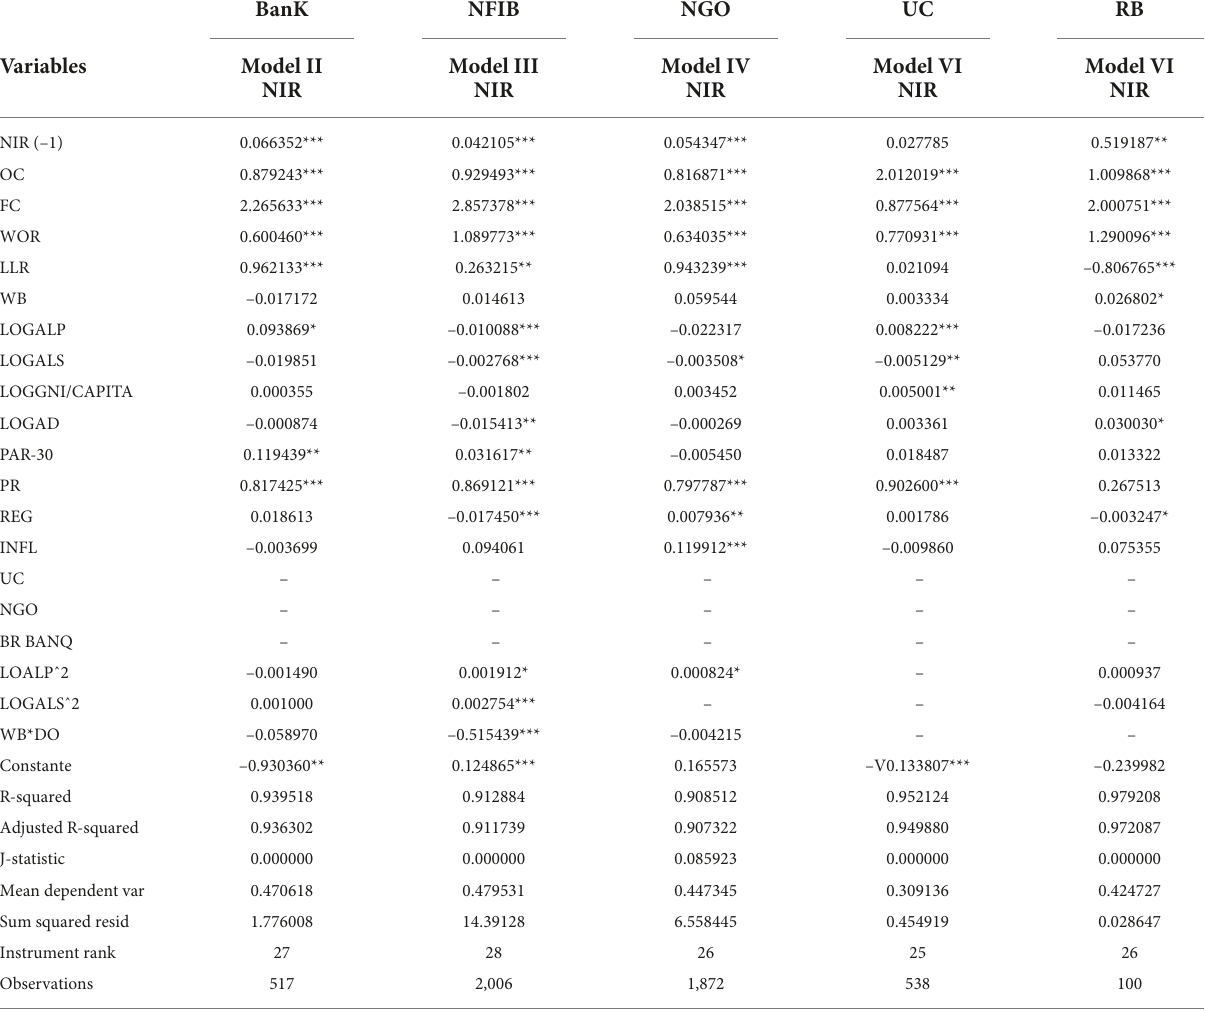
TABLE 12 Interest rate determinant according to legal